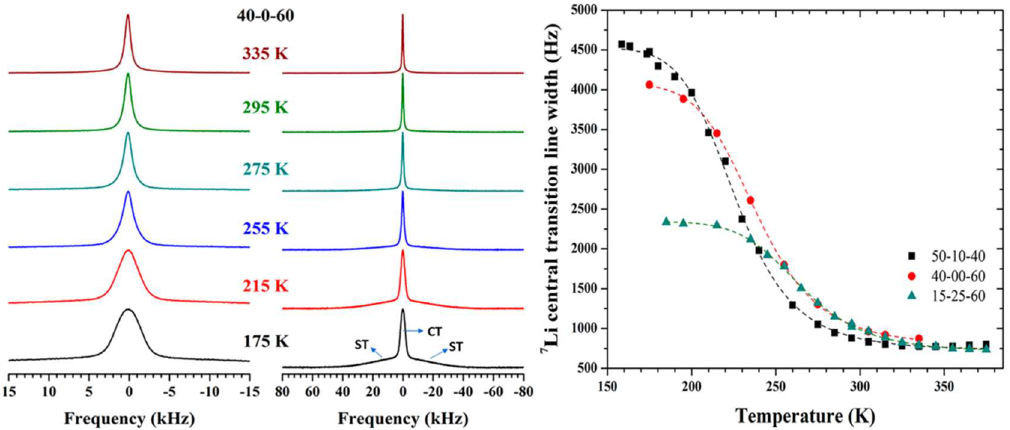
Figure 4. (Left) Static 7 Li NMR spectra with temperature in the 40–60 Li 2 S–GeSe 2 glass. (Right) Motional narrowing of both the central transition (CT) peak is clearly seen at elevated temperatures [16] .